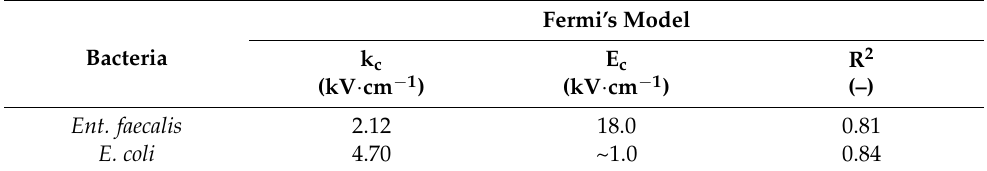
Table 2. Modeling results of PEF inactivation kinetics of two indicator bacteria using Fermi’s model.